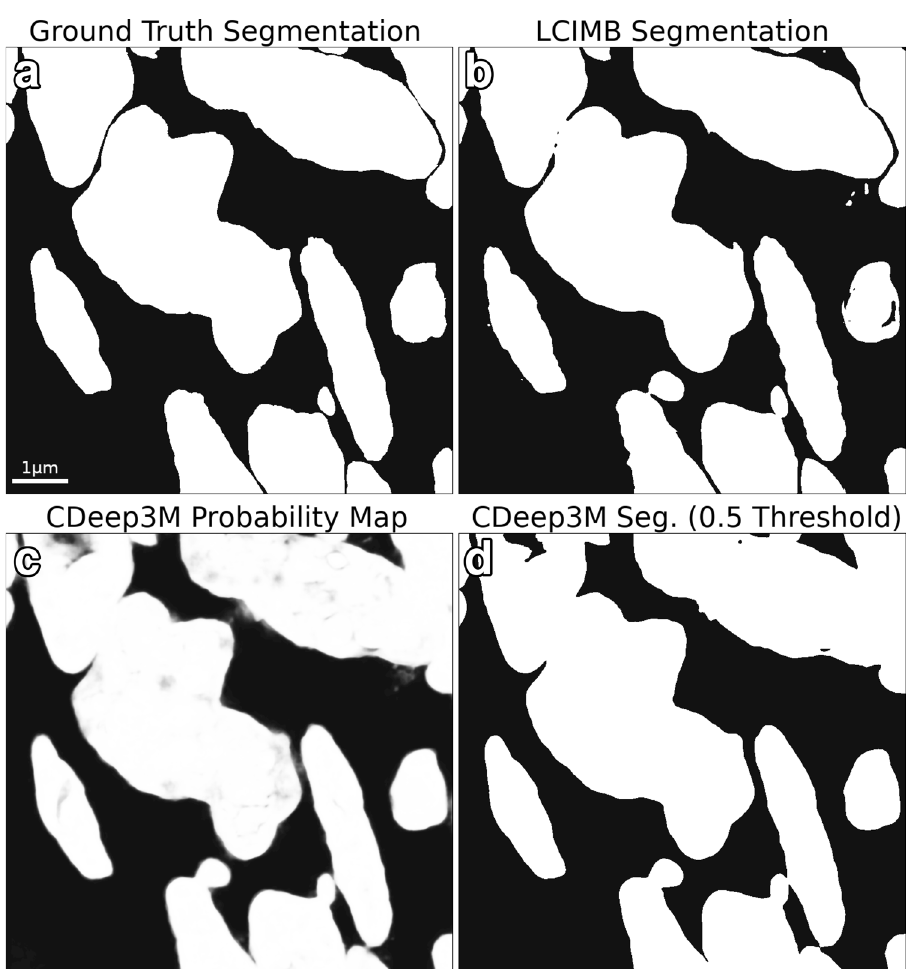
Figure 4. CDeep3M segmentation comparison. Comparison between the CDeep3M segmentation tool and our lab’s (LCIMB) best segmentation algorithm for a binary cell/non-cell segmentation problem on our evaluation dataset. ( a ) Orthoslice of the ground truth binary segmentation of the evaluation dataset. ( b ) Segmentation using our lab’s (LCIMB) best 3D ensemble. ( c ) Probability map produced by the CDeep3M ensemble after training on our data for 30000 iterations. The probability map is a per-voxel probability that the voxel belongs to a cell region, and it must be thresholded to produce a segmentation. ( d ) Segmentation from the CDeep3M ensemble with the best tested threshold of 0.5. This resulted in an MIoU of 0.935, compared to 0.946 for the LCIMB segmentation. In addition to a slight improvement in MIoU statistic, the LCIMB segmentation does a much better job of preserving boundaries between adjacent